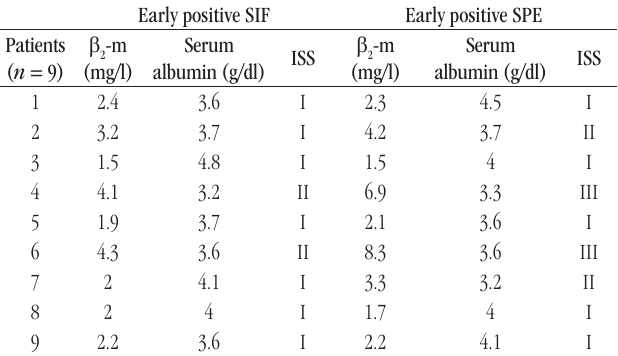
taBLE 3 − ISS of recurrent patients at early positive SIF and SPE Early positive SIF Early positive SPE